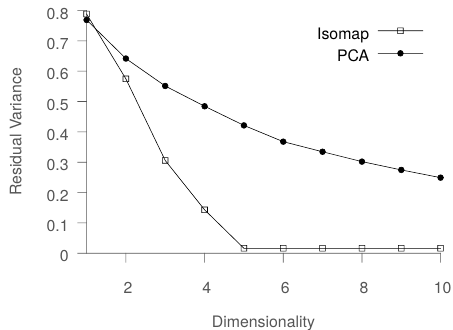
Figure 2. Isomap and principal component analysis (PCA) run on simulation output produced by data with six trajectories for χ = 3.0 and φ ∈ { 0.50,0.52,0.54,0.56,0.58,0.6 } . The quality of the Isomap manifold and PCA subspace are assessed using residual